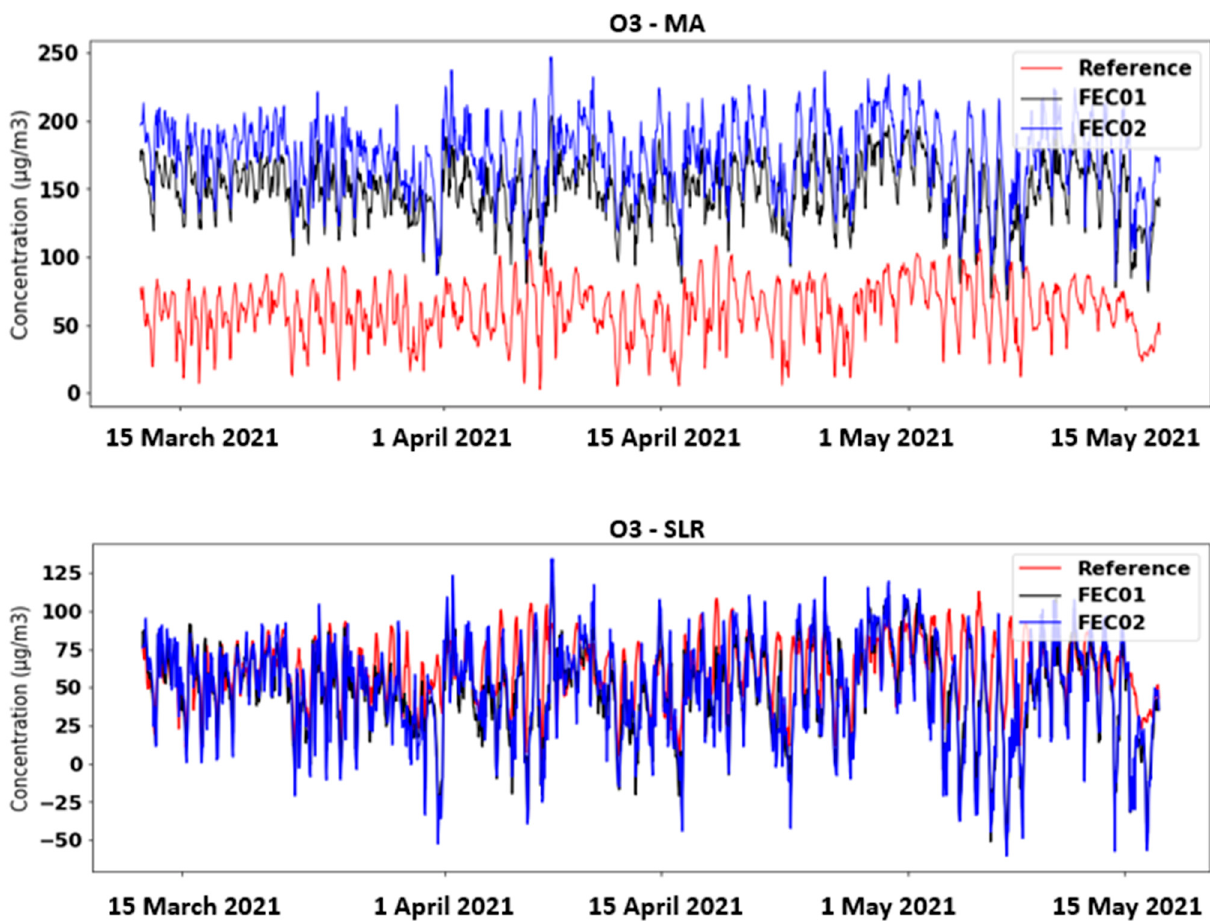
Figure 5. Time chart of O 3 concentrations obtained with MA and SLR calibration techniques.